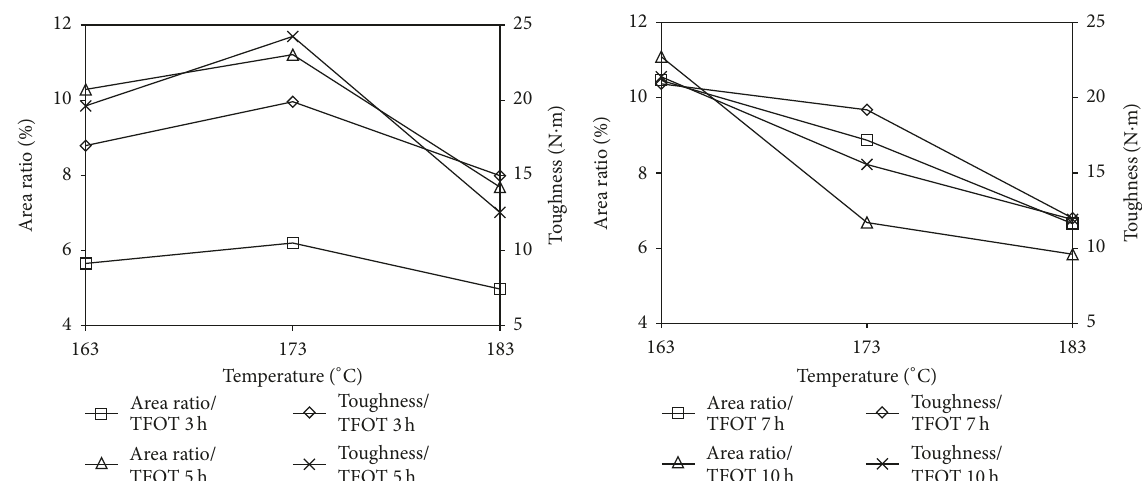
Figure 7: Correlation of SBS particle area ratio and toughness with aging temperature.